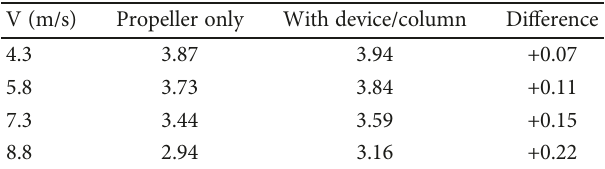
Table 8: Comparison of torque. V